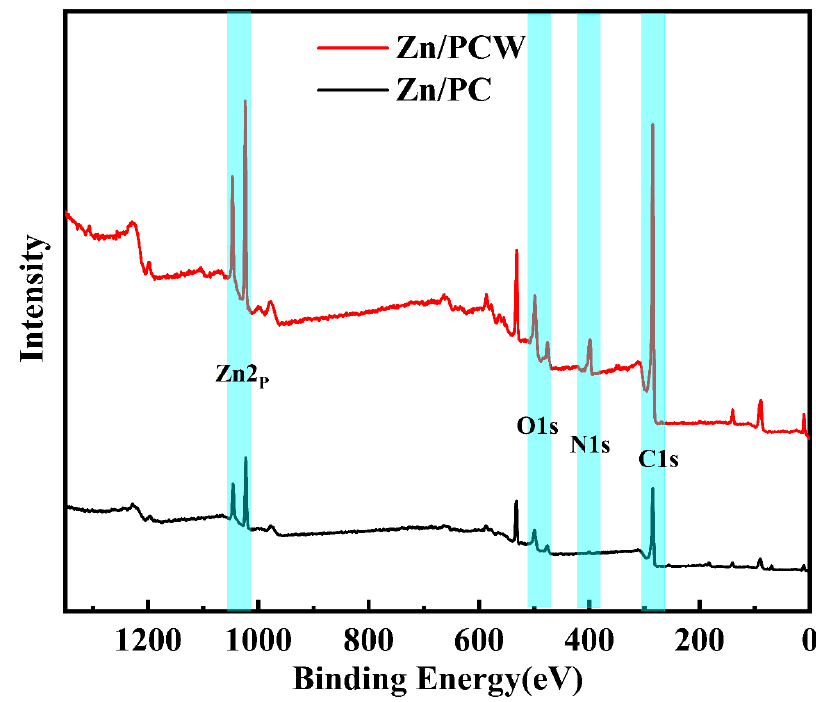
Figure 3. XPS survey spectrum of Zn/PC and Zn/PCW.